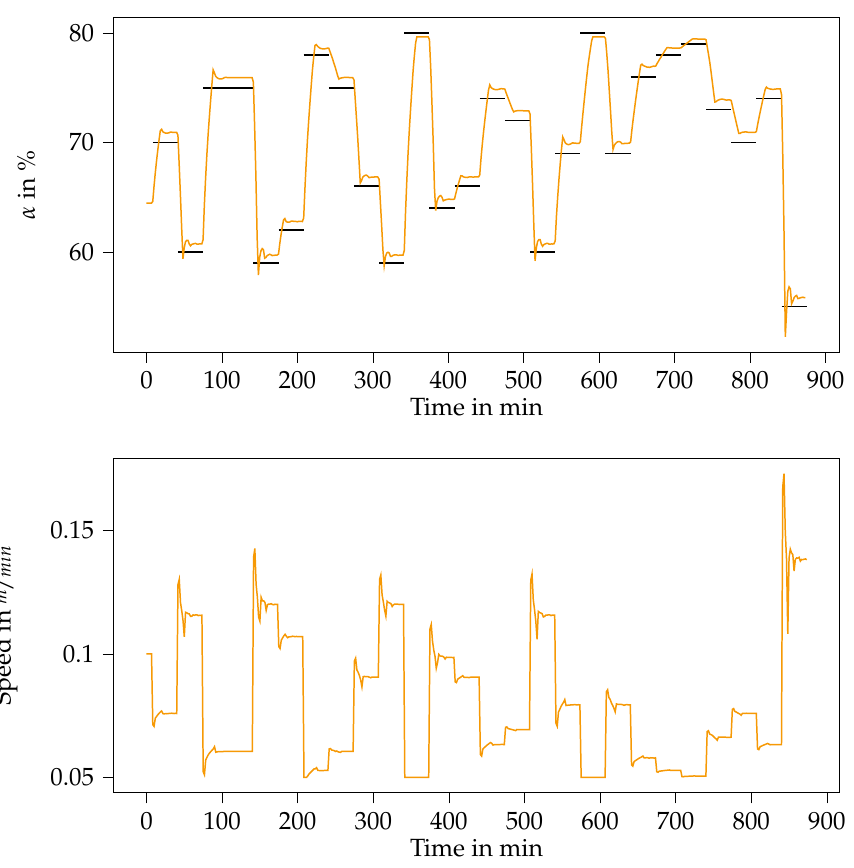
Figure 7. Best run after 270 Generations with curing α in orange, the target curing black in the top figure and Speed set by the ANN in the figure at the bottom.